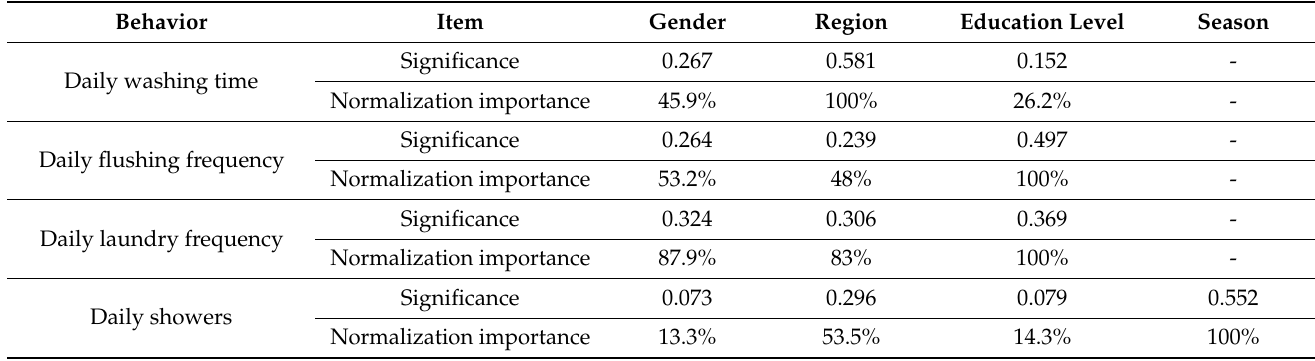
Table 3. Comparison of factors’ significance in water use behaviors.